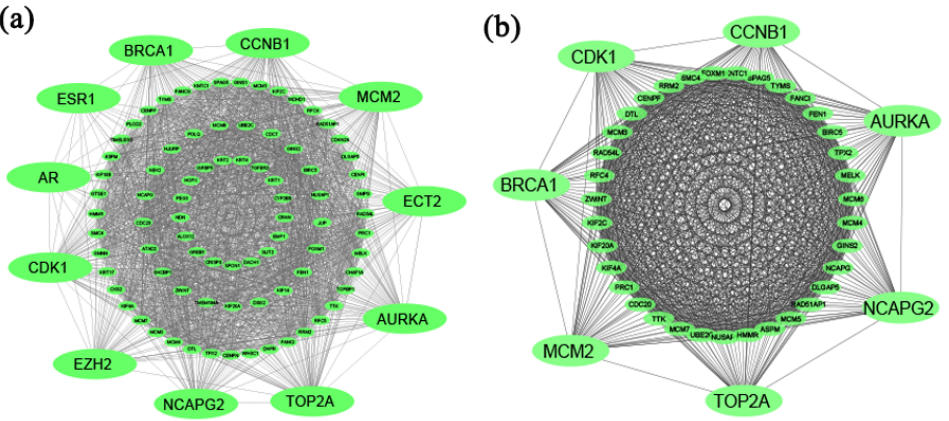
Figure 3. ( a ) Protein–protein interaction network for common differentially expressed genes of CC, and edges specify the interconnection in the middle of two genes. The analyzed network holds 92 nodes and 1790 edges. Surrounding nodes (AR, AURKA, BRCA1, CCNB1, CDK1, ECT2, ESR1, EZH2, MCM2, NCAPG2, and TOP2A) represented the hub genes. ( b ) Module analysis network obtained from MCODE analysis. Surrounding nodes (AURKA, BRCA1, CCNB1, CDK1, MCM2, NCAPG2, and TOP2A) were found to be common across 11 hub genes, so we considered these 7 genes as the key genes. The network represents highly interconnected regions of the PPI network. The network holds 42 nodes and 850 edges.